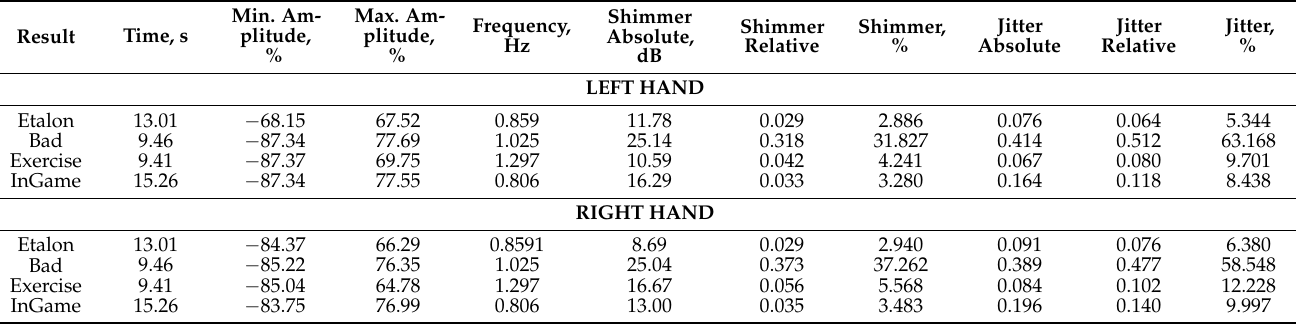
Table 6. Example of comparing the results of one iteration in Exercise 3.